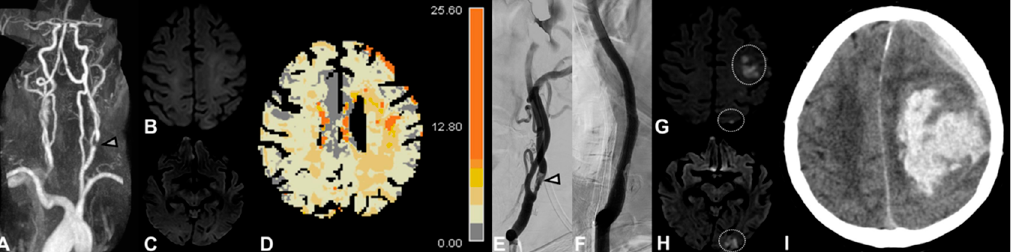
sided hemiparesis. Initial MRI (5 h from onset) did not find any intracranial large vessel occlusion,